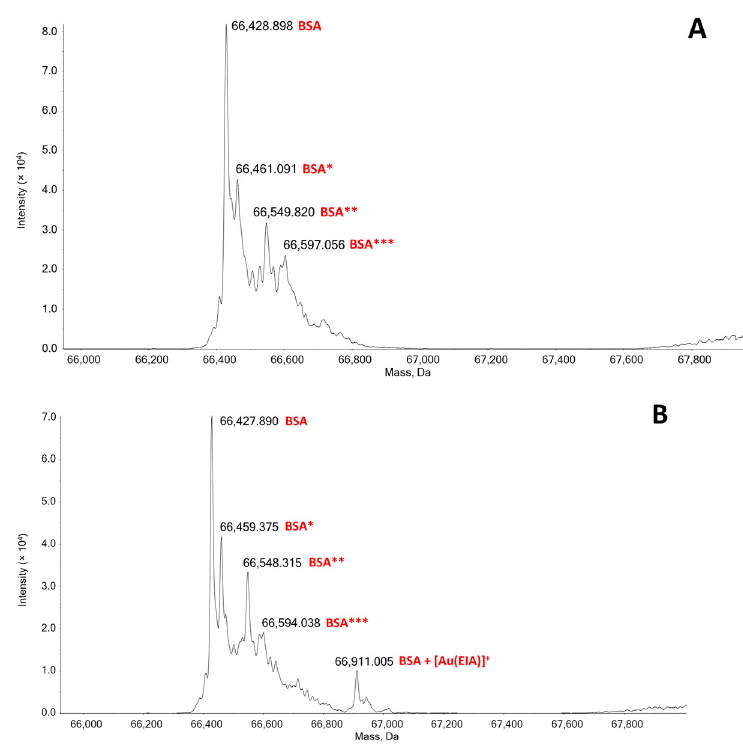
Figure 8. Deconvoluted ESI mass spectra of BSA 5.50 × 10 − 7 M ( A ) and [Au(EIA) 2 ] + / BSA ( B ) in a protein:metal ratio = 1:1.5 in 1 × 10 − 4 M ammonium acetate solution at pH 6.8 and recorded after 48 h of incubation at 37 °C. BSA* = sulfinilation on Cys-34; BSA** = cysteinylation on Cys34; BSA*** = glycosylated form of BSA.